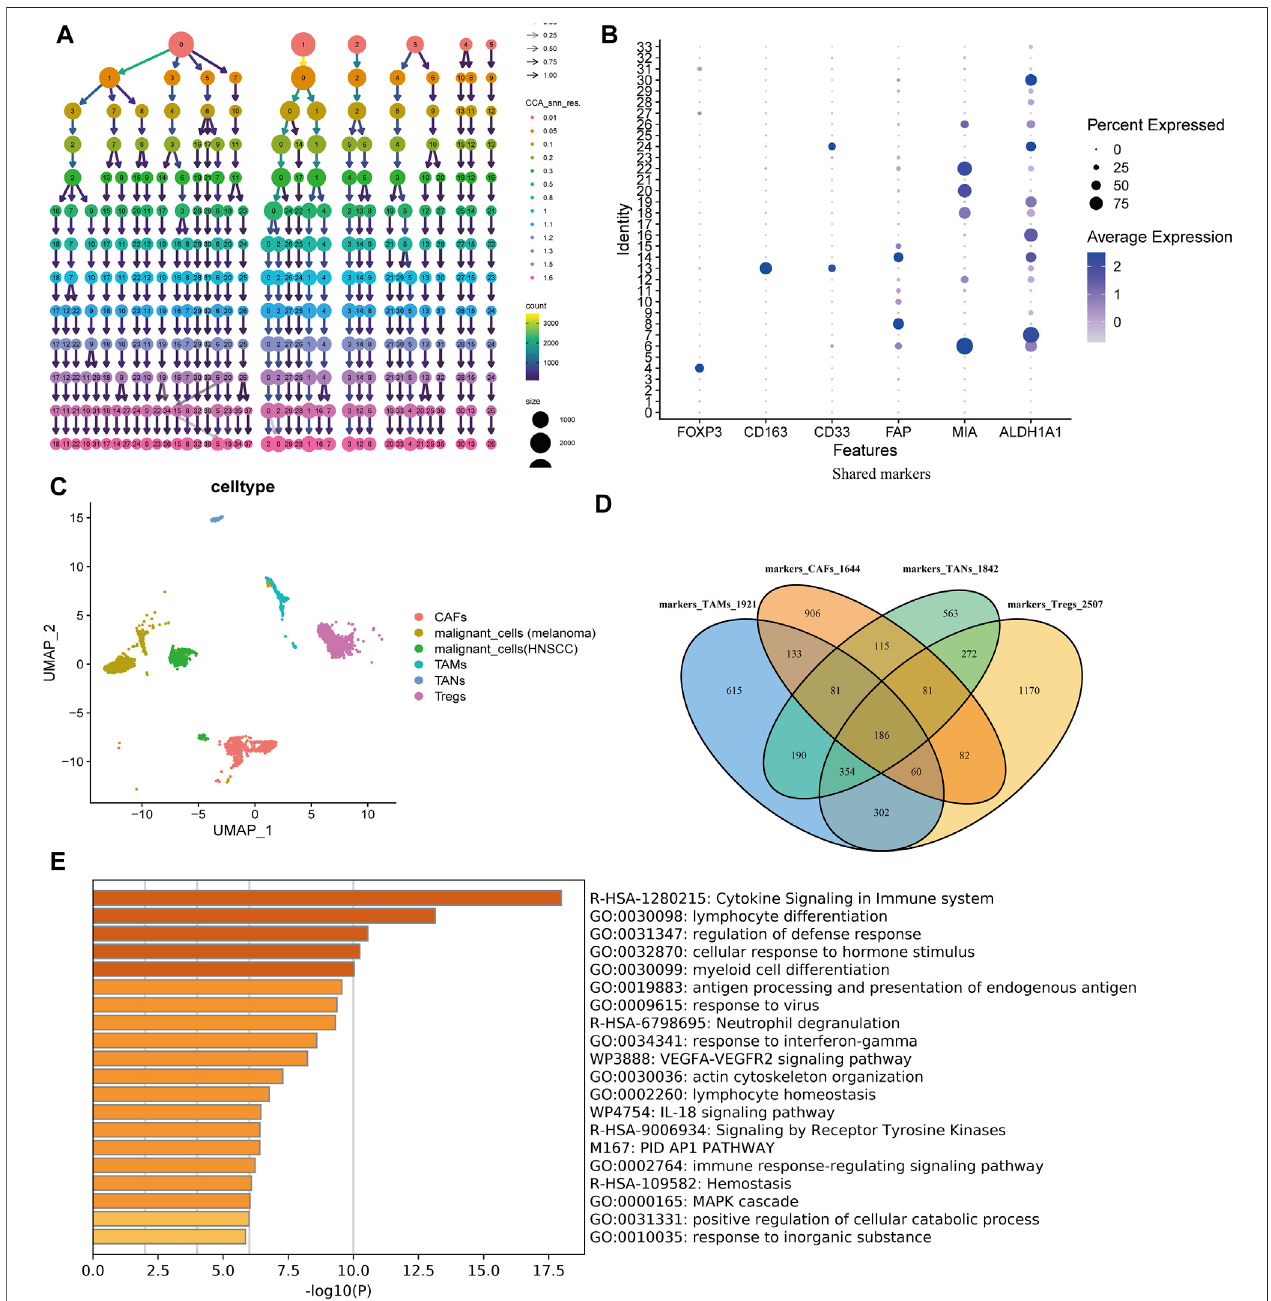
FIGURE 1 | Cell type annotation and positive marker identi fi cation. (A) Optimal resolution deciding dendrogram. Under the resolution of 1.3, all cells achieved the optimal clustering and no mixed cells in the same cluster. (B) Cell type-speci fi c markers. (C) Clustering and annotating immunosuppressive cells (CAFs, TAMs,